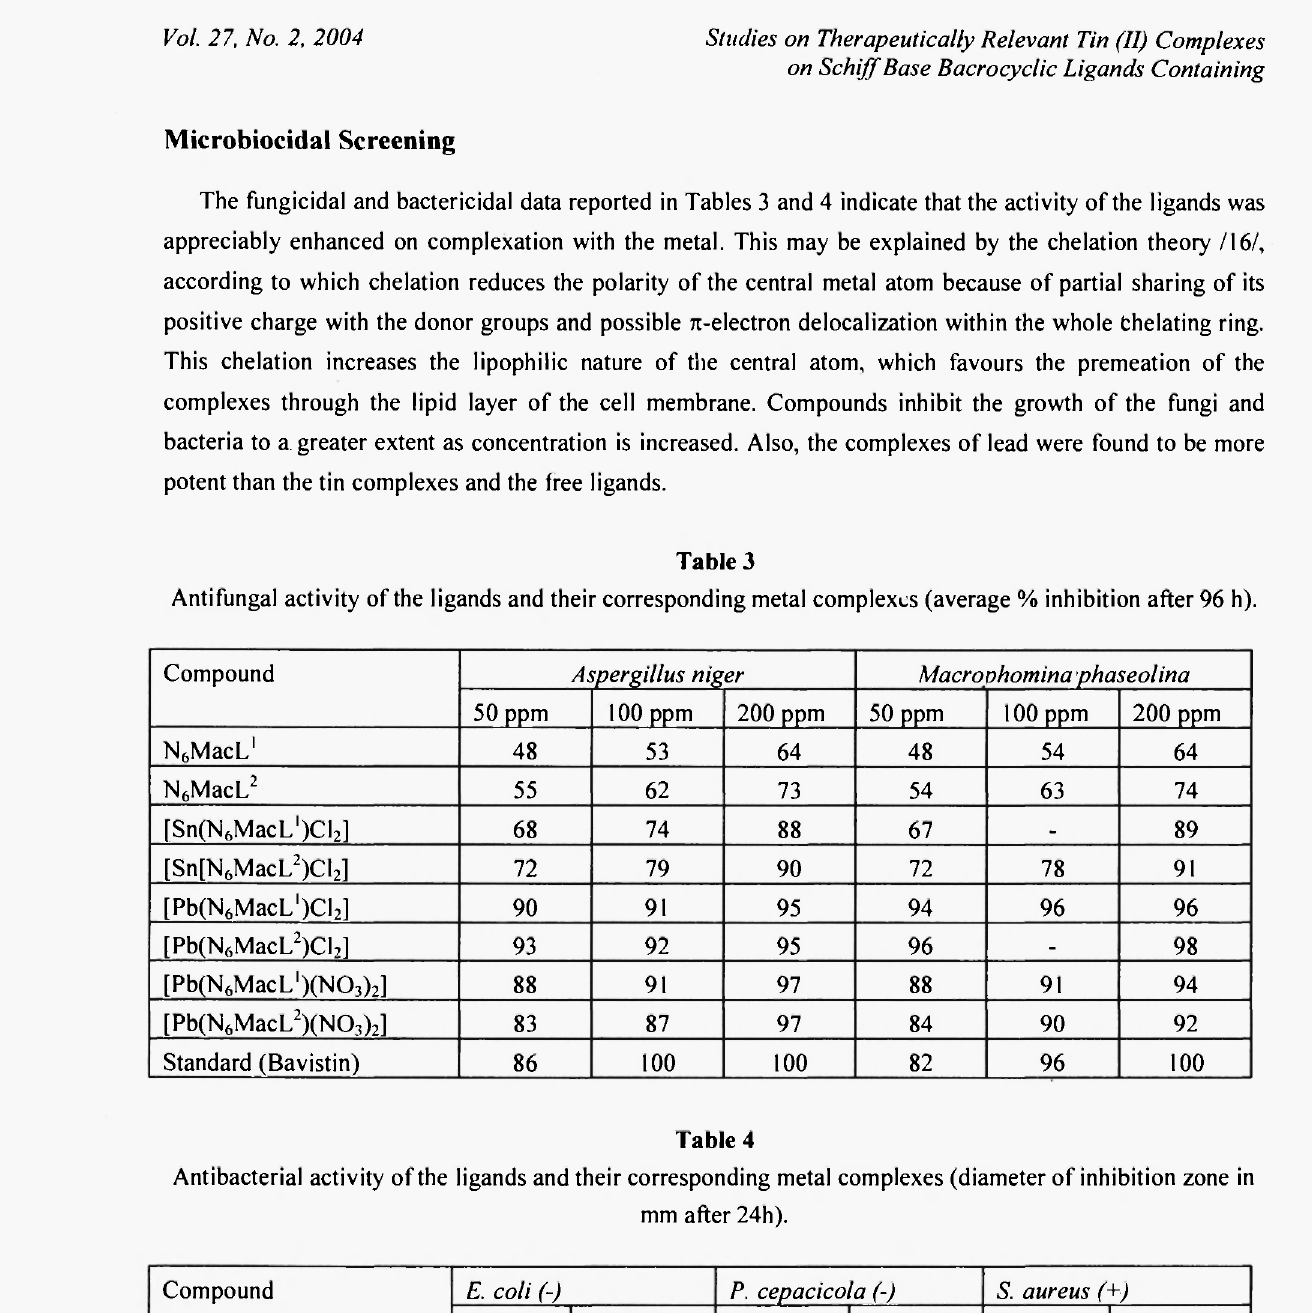
Antibacterial activity of the ligands and their corresponding metal complexes (diameter of inhibition zone in